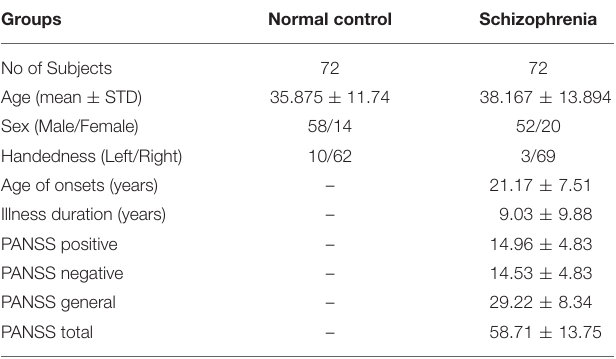
TABLE 1 | Demographic information of subjects from COBRE